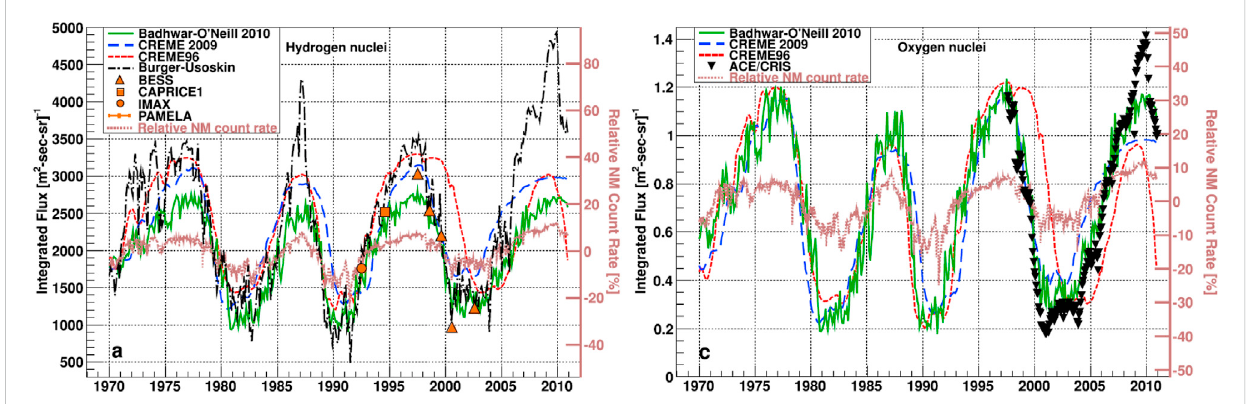
The evolution of the fl ux of O + downtail streaming beams, as a function of the tailward distance from the Earth, is shown in Figure 6 (from Seki et al., 1998). During high geomagnetic activity conditions these beams include heavy atomic and molecular ions (Christon et al., 1994; Christon et al., 2020). Closer to the Moon, O + downtail streaming beams have been observed by the Kaguya Lunar Orbiter (Terada et al., 2017). The spectral characteristics of these streaming O + ions show a clear distinction between the O + ions of lunar origin (few